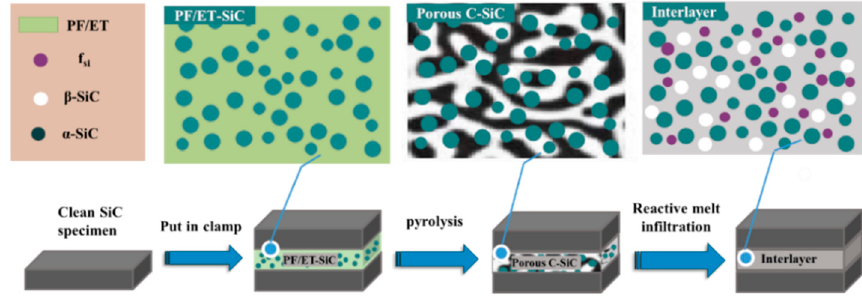
Figure 1. Schematic of preparation of SiC-SiC joining.